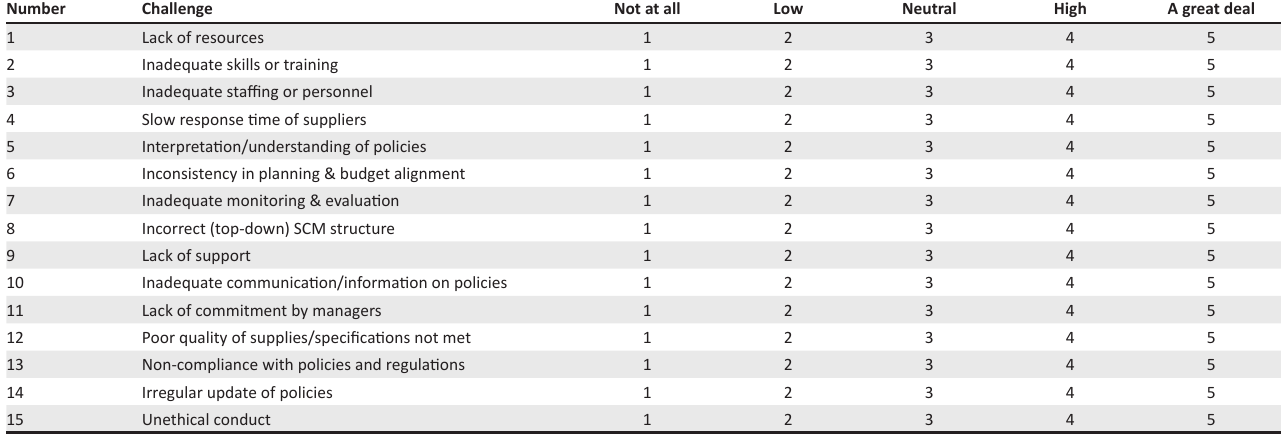
TABLE 2: Instrument measuring the extent to which challenges affected the implementation of the supply chain management policy. Number